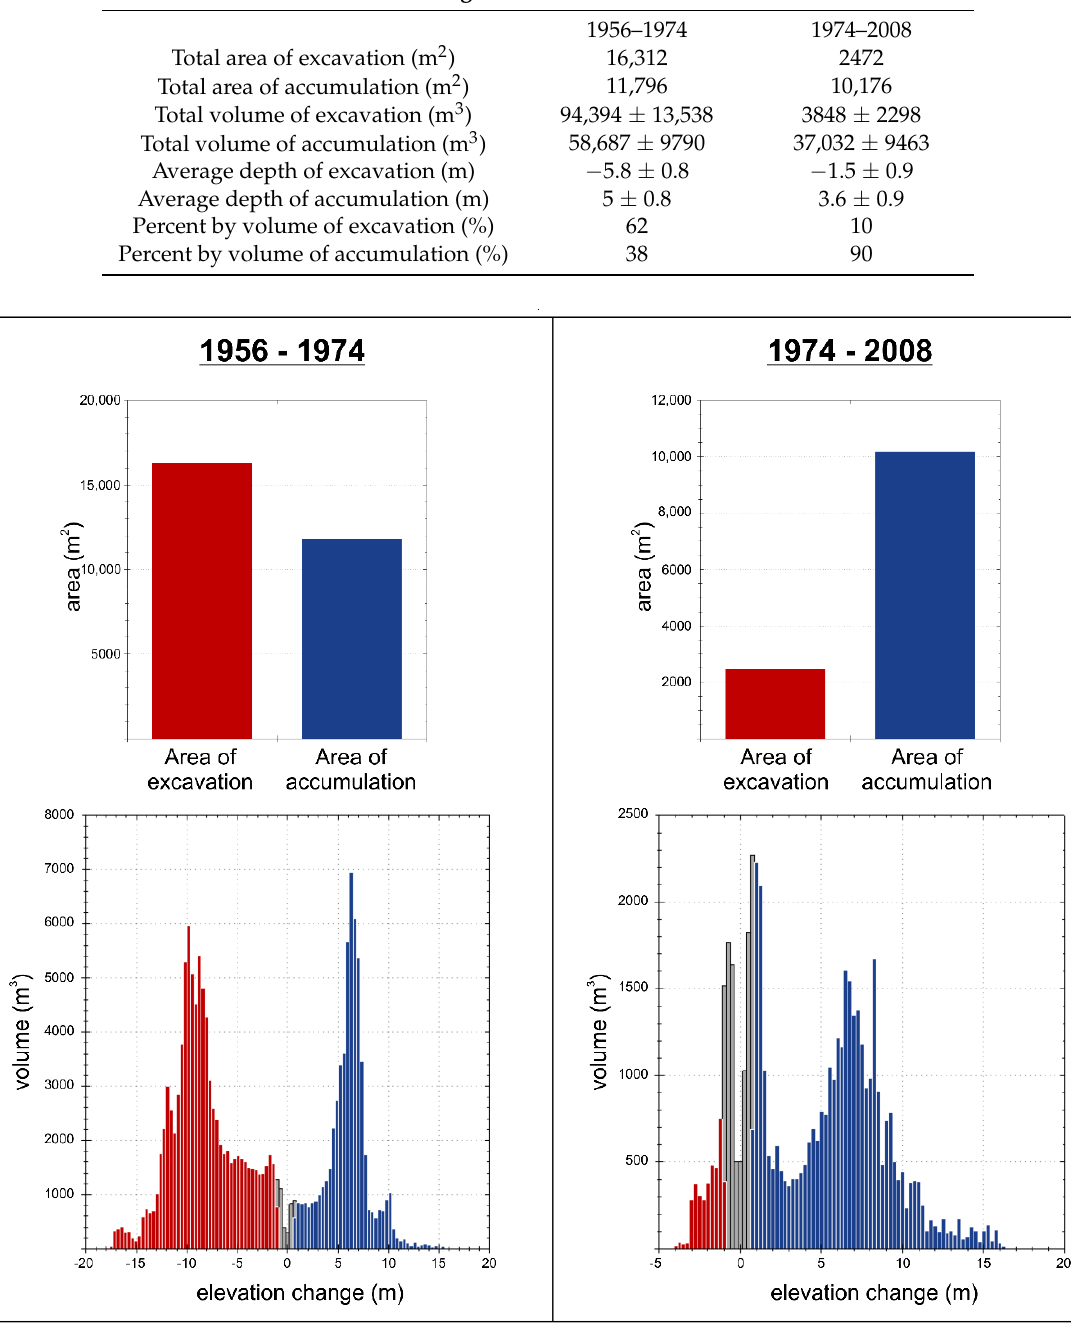
Figure 6. Statistical distribution of both areal ( above ) ad volumetric elevation changes ( below ) obtained by the multi-temporal change detection analyses. Gray bars indicate changes beneath the error threshold that have been excluded from quantitative assessment.